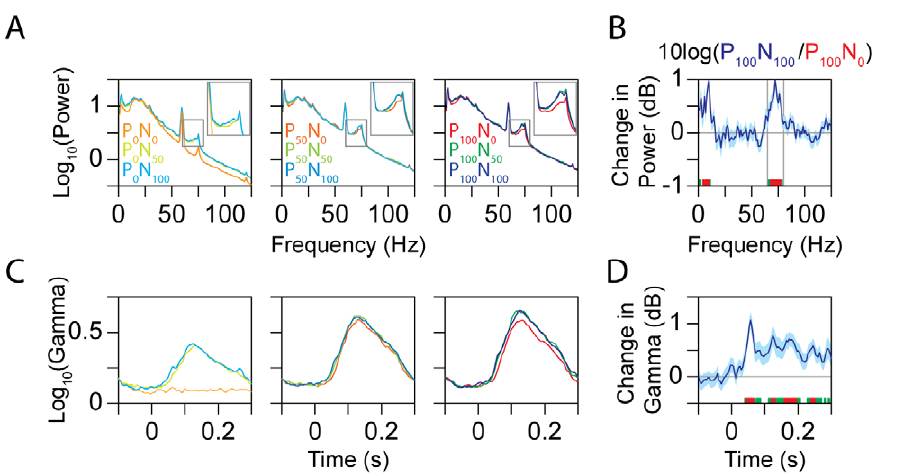
Figure 4. LFP power as a function of frequency and time. (A) Power spectra for different normalization conditions. (B) Change in power when both preferred and null stimuli are presented at 100% contrast (P 100 N 100 ) versus when only a preferred stimulus is presented (P 100 N 0 ). The shaded area represents the SEM. The frequency bins for which the change is significantly different are indicated by green ( p , 0.01, no Bonferroni correction) and red ( p , 0.05, Bonferroni corrected) squares at the bottom of the plot. Gray lines indicate the gamma range. (C) Gamma power (65–80 Hz, excluding 74–76 Hz) as a function of time, for different normalization conditions (same convention as A). (D) Change in gamma power between P